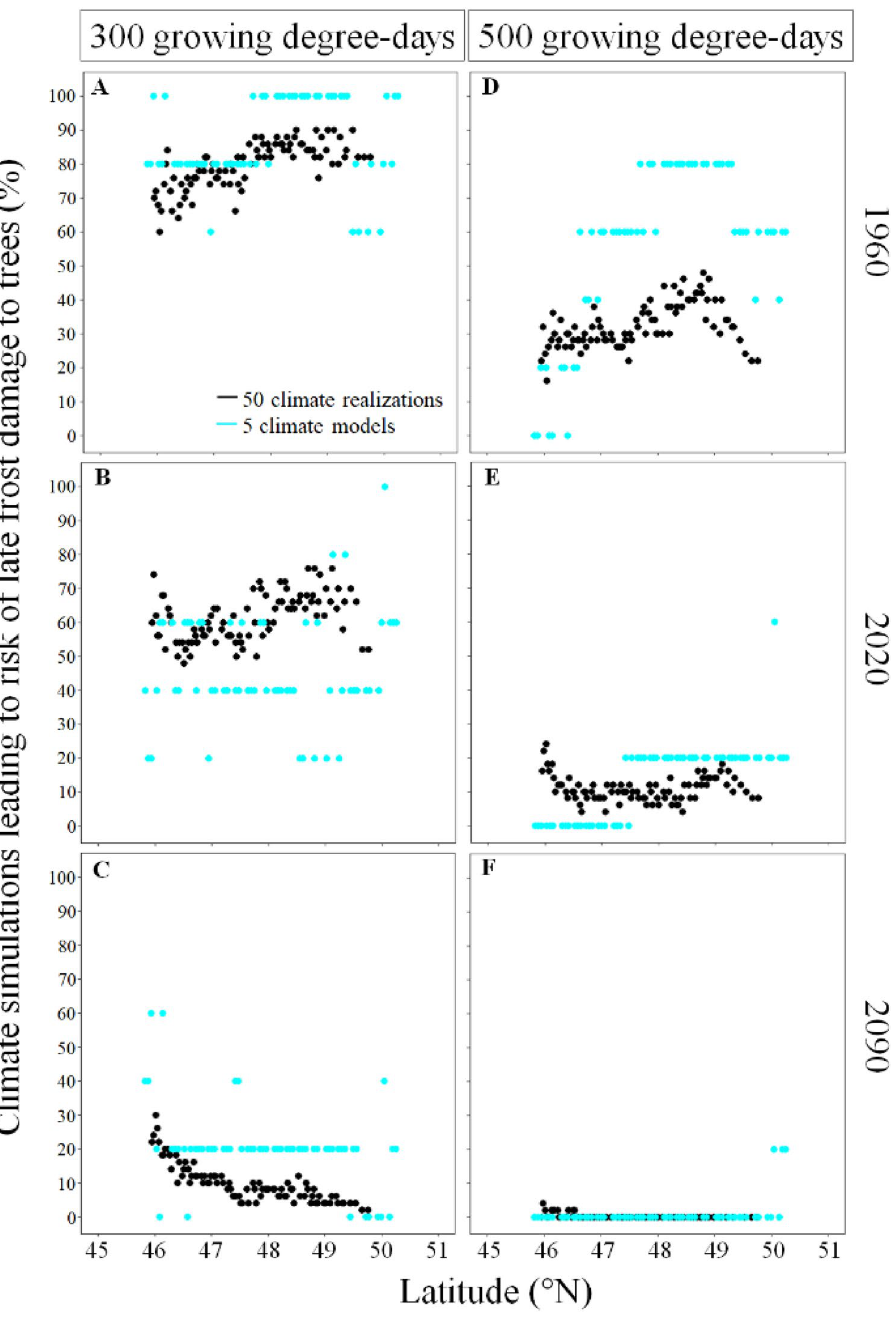
Figure 8. Inter- and intra-climate model variability in projected risk of frost exposure to early and late leaf-out species along the latitudinal gradient for three specific years (1960, 2020, 2090). The columns show the growing degree-day threshold used to represent early and late leaf-out species (300 and 500 GDD) and the rows show the specific years. We used the ggplot2 library developed by Wickham 27 to produce the